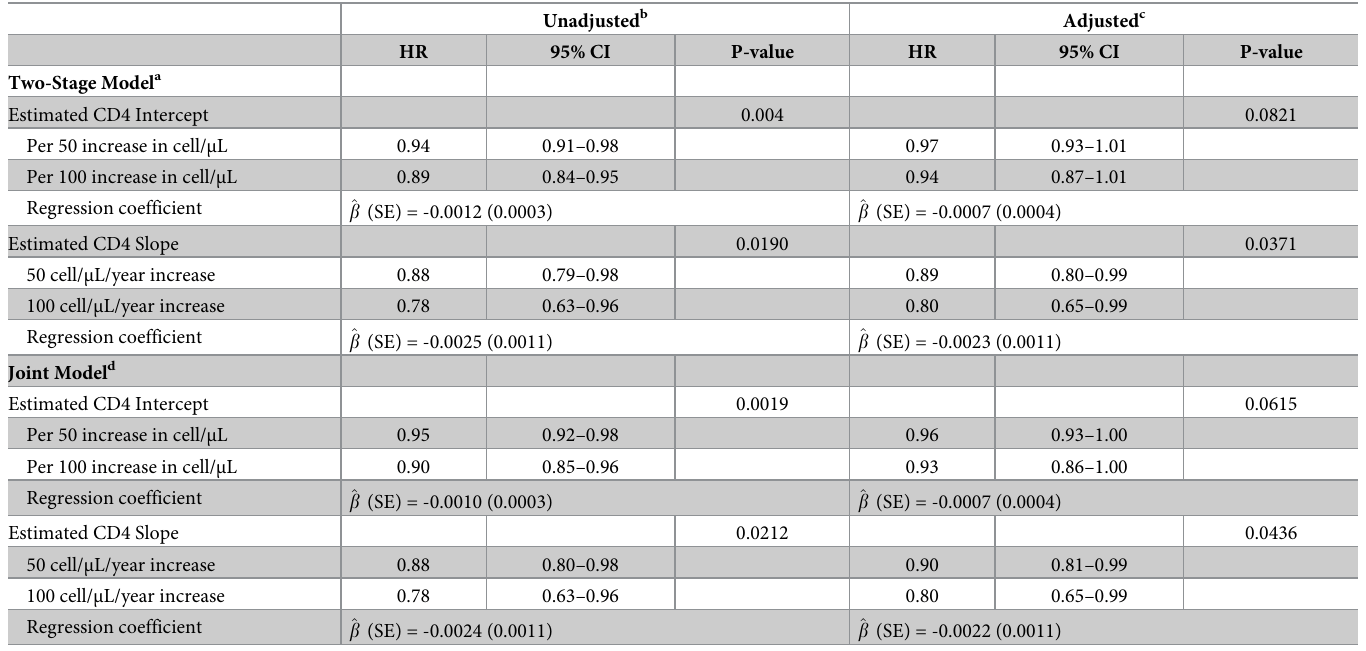
Table 3. Association between estimated CD4 intercept and CD4 slope during the two years following ART initiation with risk of composite endpoint a